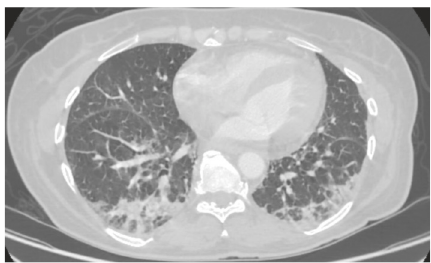
Figure 1: CT chest w/o contrast showing ground-glass opacities, bronchiectasis, and increased interstitial